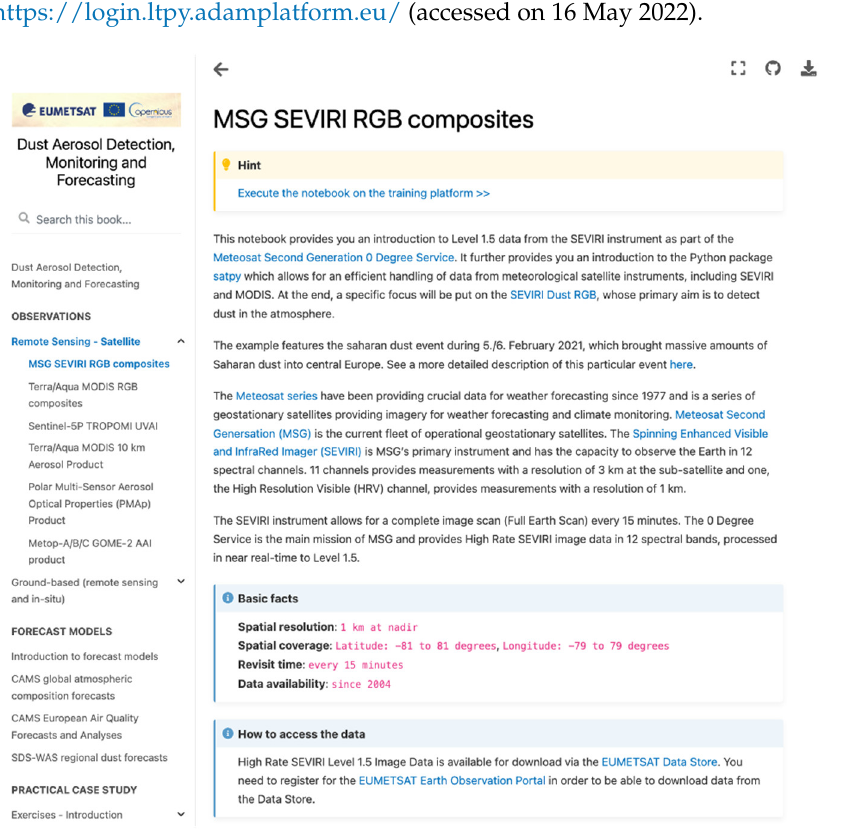
Figure 2. Screenshot of the Jupyterbook on dust aerosol detection, monitoring and forecasting, which can be accessed via https://dust.trainhub.eumetsat.int/ (accessed on 16 May 2022). The example shows a subpage introducing the Meteosat Second Generation SEVIRI Level 1B data. Each data subpage has on top a link to the executable notebook on a JupyterHub-based training platform and info boxes on ‘basic facts’ and ‘How to access the data’.